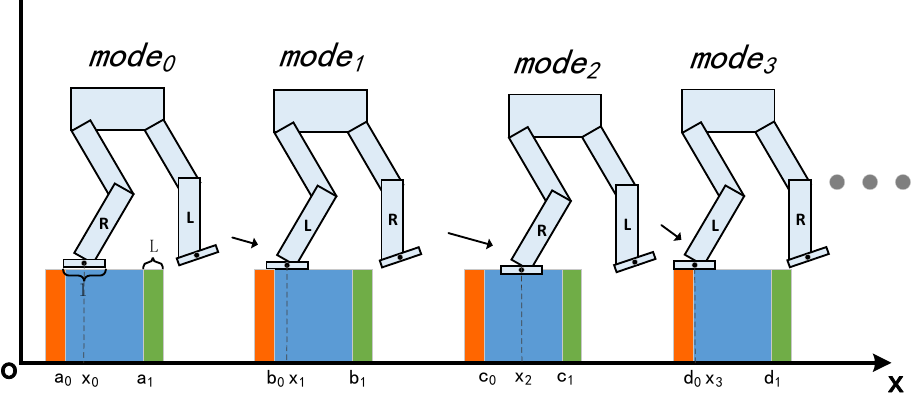
Figure 2. The four selections of supporting foot location where mode0 and mode2 are the desired selections. x (cid:2868) , x (cid:2869) , x (cid:2870) and x (cid:2871) are the are the center of supporting foot and [a (cid:2868) , a (cid:2869) ] , [b (cid:2868) , b (cid:2869) ] , [c (cid:2868) , c (cid:2869) ] and [d (cid:2868) , d (cid:2869) ] are the safe areas. If the supporting foot is located in green or orange area, robot will be at the risk of falling.